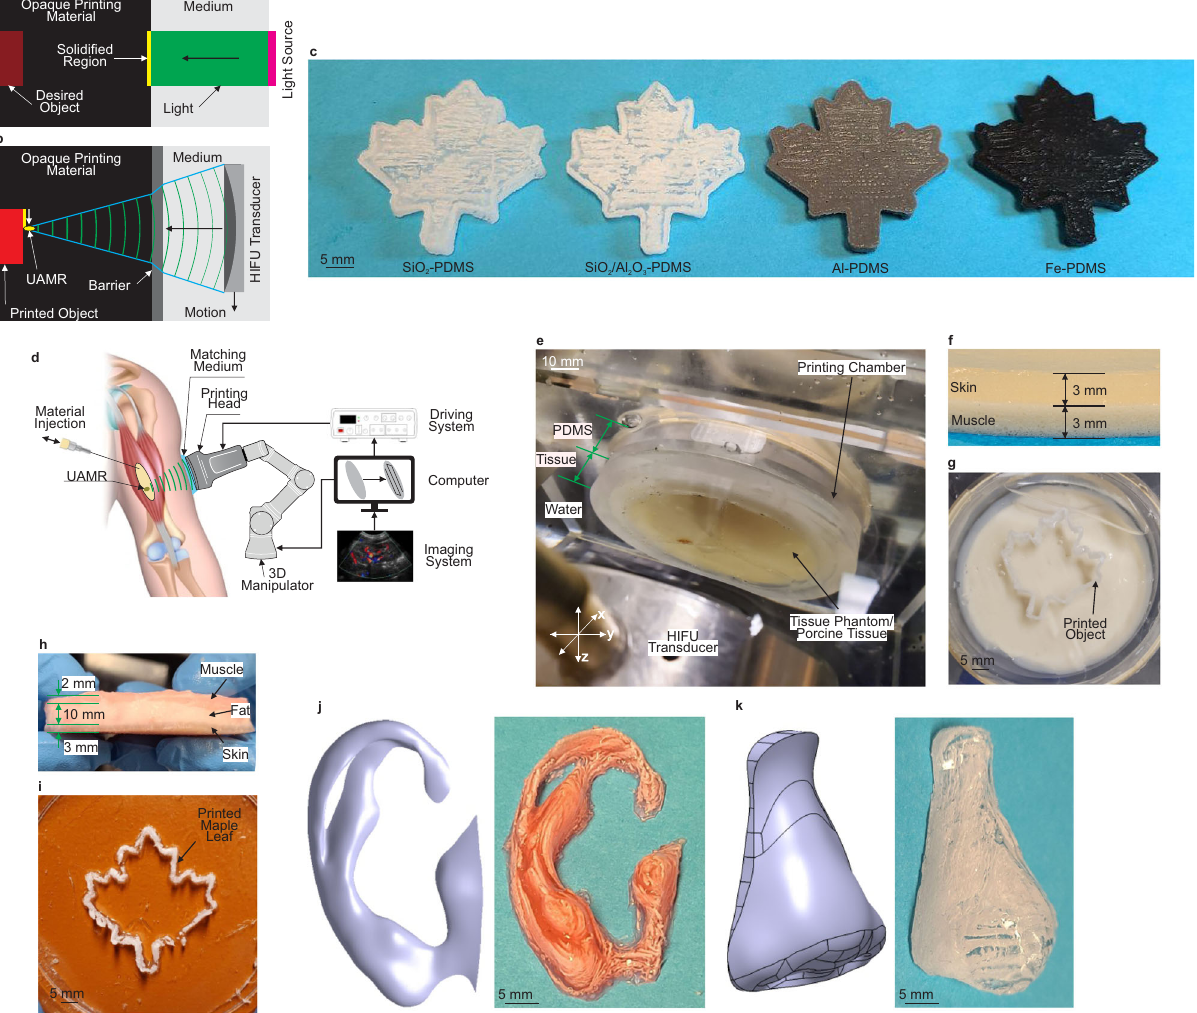
Fig. 5 Potential applications of DSP. a Light-based AM and small cure depth for opaque printing materials. b DSP and deep penetration of ultrasound in opaque printing materials. c Printing opaque micro/nano composites by DSP. d The concept of an ideal DSP technology for noninvasive inside body printing. e in-vitro/ex-vivo prove of concept setup. f Tissue phantom of human skin and muscle. g A printed maple leaf using the tissue phantom. h Real porcine tissue compromising skin, fat and muscle. i Printed maple leaf using the porcine tissue. j and k Printed ear and nose using the tissue phantom. (HIFU: high-intensity focused ultrasound, UAMR: ultra-active micro reactor, PDMS: